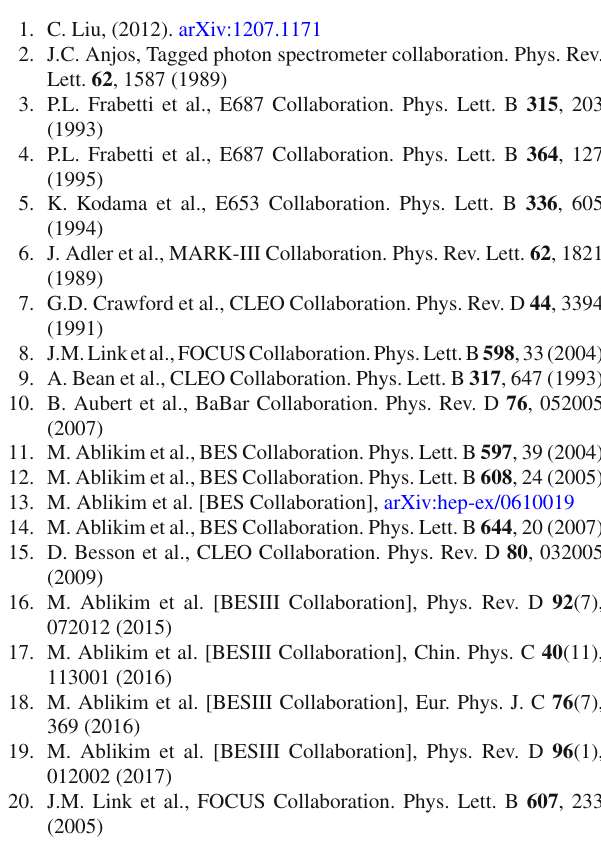
parameter series expansion form factors, we obtain the prod- uct of form factor f K + ( 0 ) and the magnitude | V cs | and the shape parameters of both vector and scalar form factors f K + ( 0 ) | V cs | = 0 . 7182 ± 0 . 0029 , r + 1 = − 2 . 16 ± 0 . 007 , r 01 = 0 . 89 ± 3 . 27